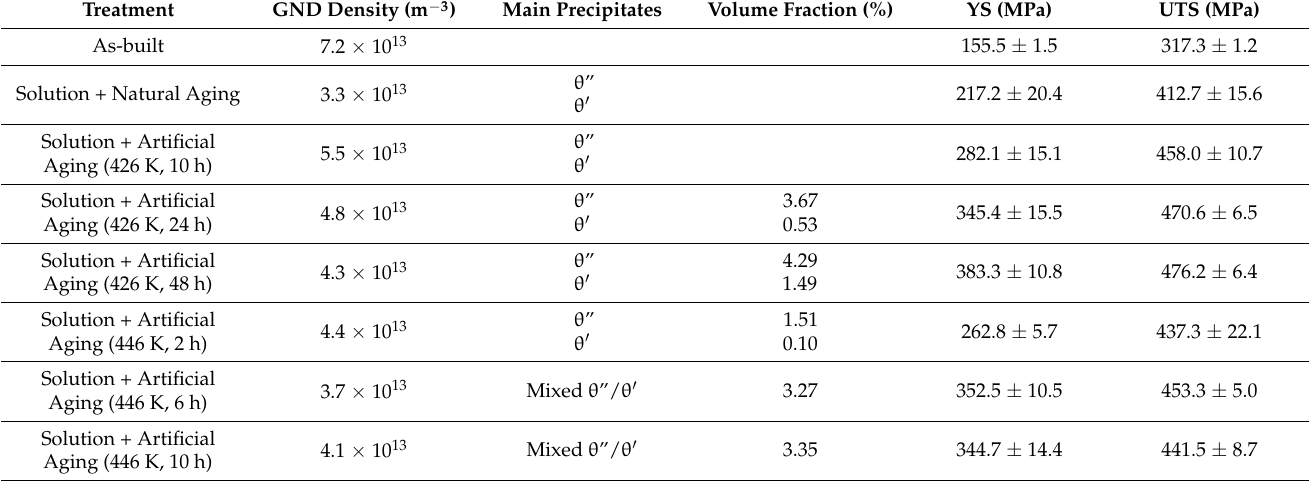
Table 3. Effect of different heat treatments on AM205A alloy: geometrically necessary dislocations (GND), type of precipitate phases, their volume fraction, yield stress (YS), and ulti- mate tensile strength (UTS). Data taken from ref.